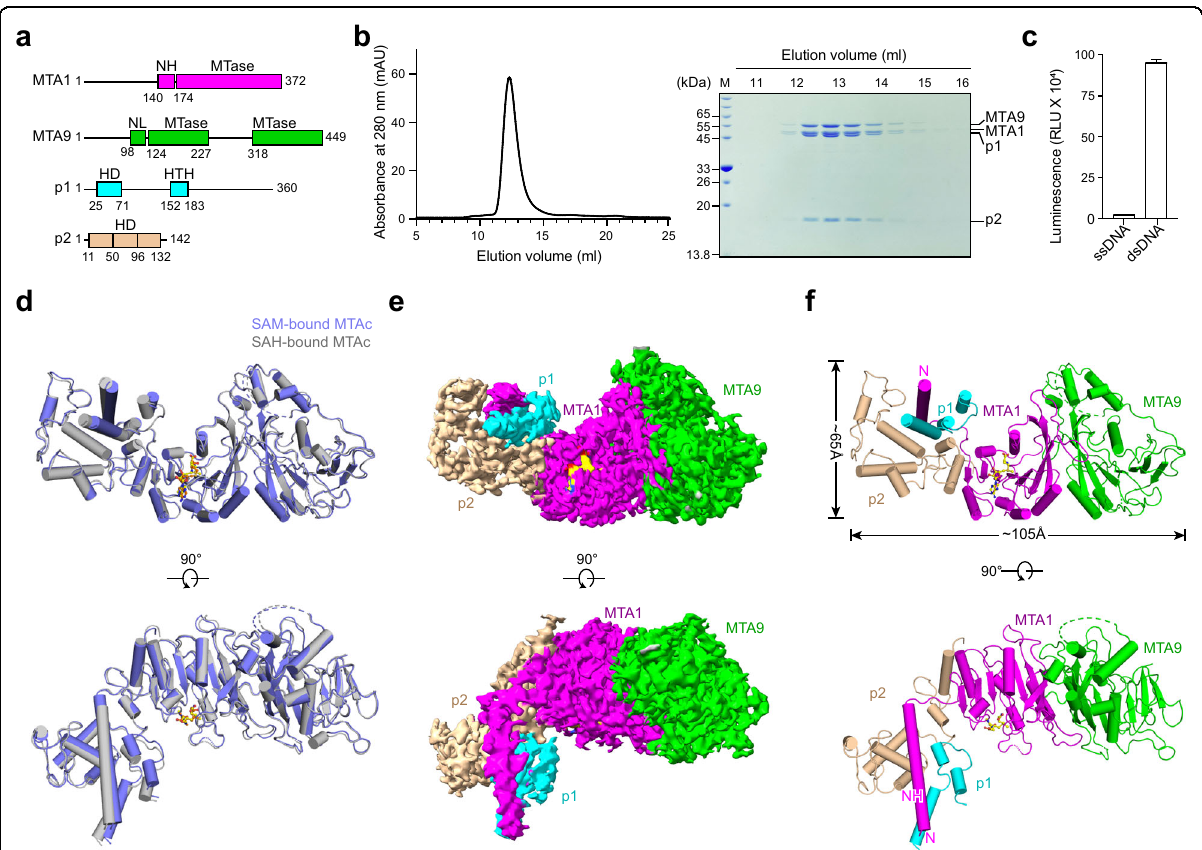
Fig. 1 Overall structure of the co-factor substrate-bound MTA1 complex. a Schematic diagram of the domain information of the MTA1 complex. NH, N-terminal helix; NL, N-terminal loop; HD, homeobox-like domain; HTH, helix-turn-helix-like domain. b Left panel, a representative gel fi ltration chromatography of the MTA1 complex; right panel, SDS-PAGE gel showing proteins present in the peak fractions of the MTA1 – MTA9 – p1 – p2 heterotetramer from the left panel. c SAM-dependent methyltransferase assay (MTase-Glo assay) using 27-bp oligonucleotides. The error bars represent the SEM of three independent measurements. The experiment was repeated twice. ssDNA, single-stranded DNA; dsDNA, double-stranded DNA. d Superposition of the SAM-bound (slate) and SAH-bound (gray) MTA1 complexes. SAM and SAH are shown as yellow and orange balls-and- sticks, respectively. e Cryo-EM density of the SAM-bound MTA1 complex. MTA1, MTA9, p1, p2, and SAM are shown in magenta, green, cyan, wheat, and yellow, respectively. f Atomic model of the MTA1 complex in cartoon, with the same color scheme as e